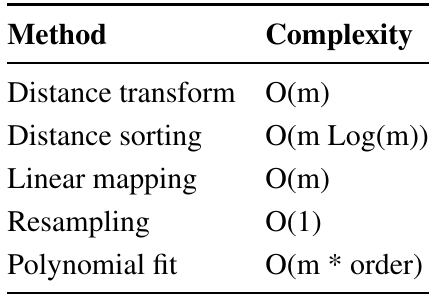
Table 2. Complexity of connected component processing steps. m is the number of pixels in a connected component. order is the polynomial order of the fitted